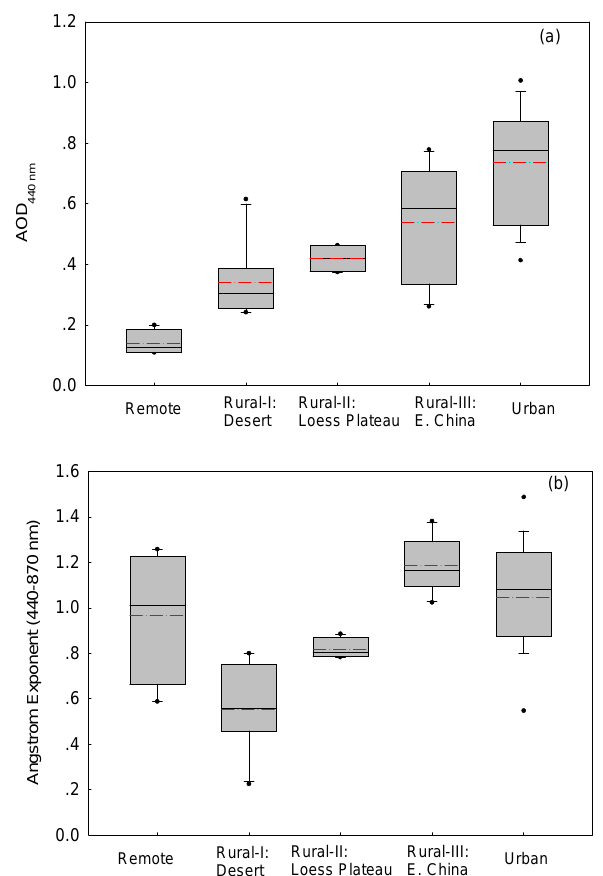
Figure 4. (a) AODs at 440nm and ( b ) AEs between 440 and 870nm at remote, rural, and urban regions of